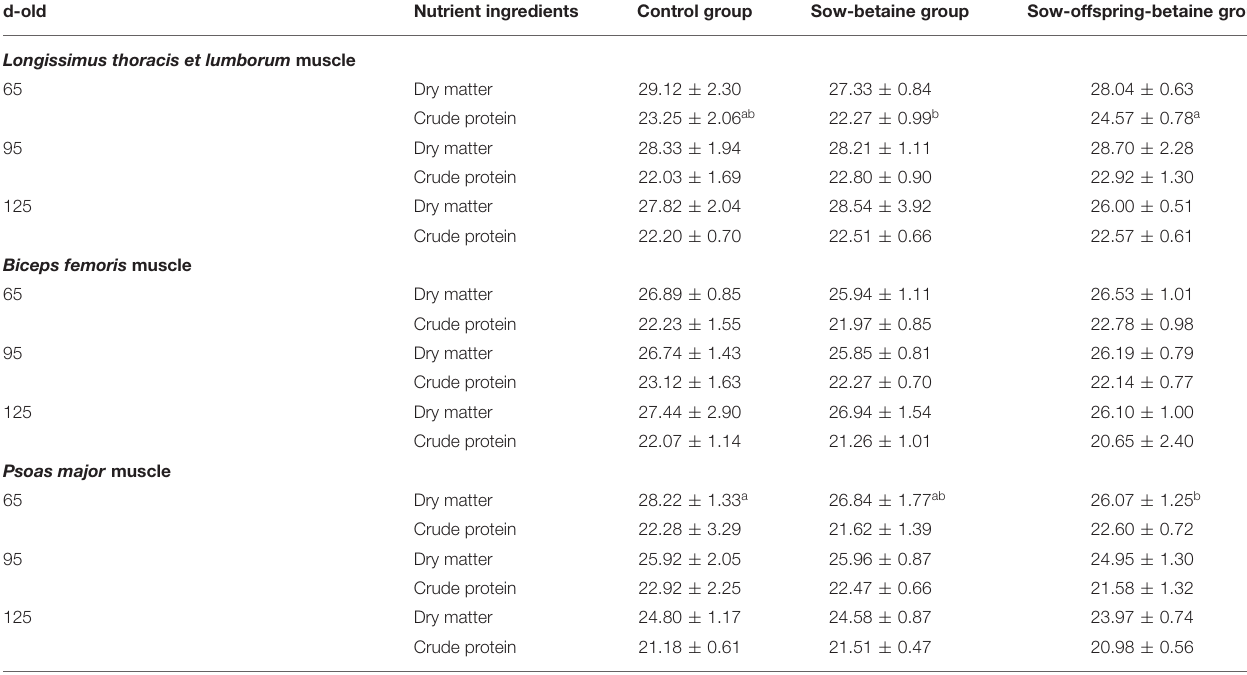
TABLE 3 | Effect of dietary betaine on routine nutrient contents of Bama mini-pigs (fresh weight basis; %). d-old Nutrient ingredients Control group Sow-betaine group Sow-offspring-betaine group Longissimus thoracis et lumborum